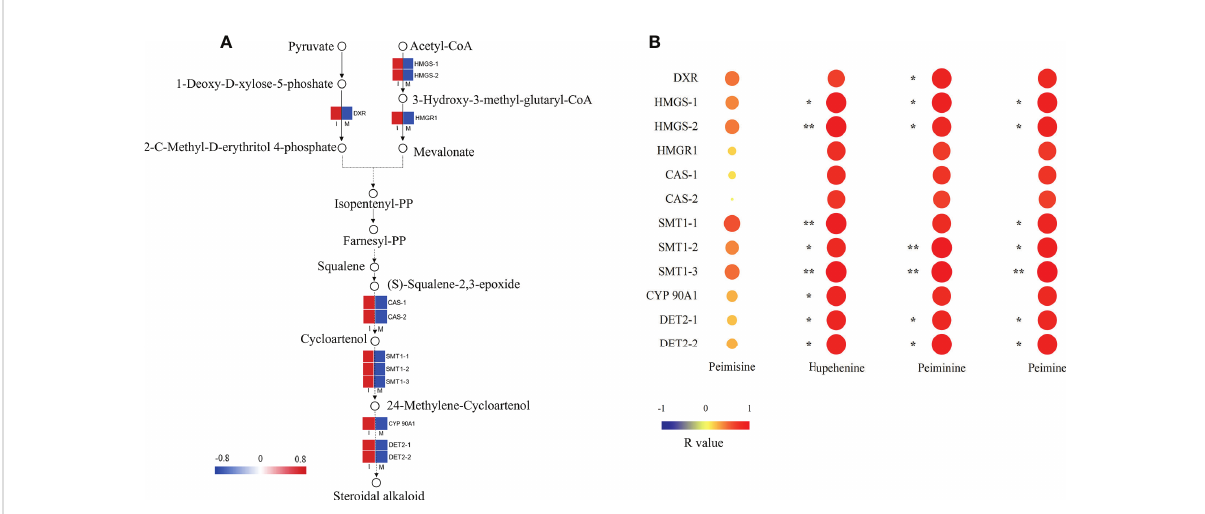
FIGURE 4 Key DEG analysis in steroid alkaloid biosynthesis. (A) Expression pro fi les of DEGs in the steroidal alkaloid biosynthesis pathway. Red color denoted genes with high expression level, while blue color denoted genes with low expression level. The relative expression levels of DEGs were calculated using log2 ratio. (B) Heat map of correlation between FPKM values of DEGs and main steroidal alkaloids, the correlation was indicated by Pearson r value (* p <0.05; ** p